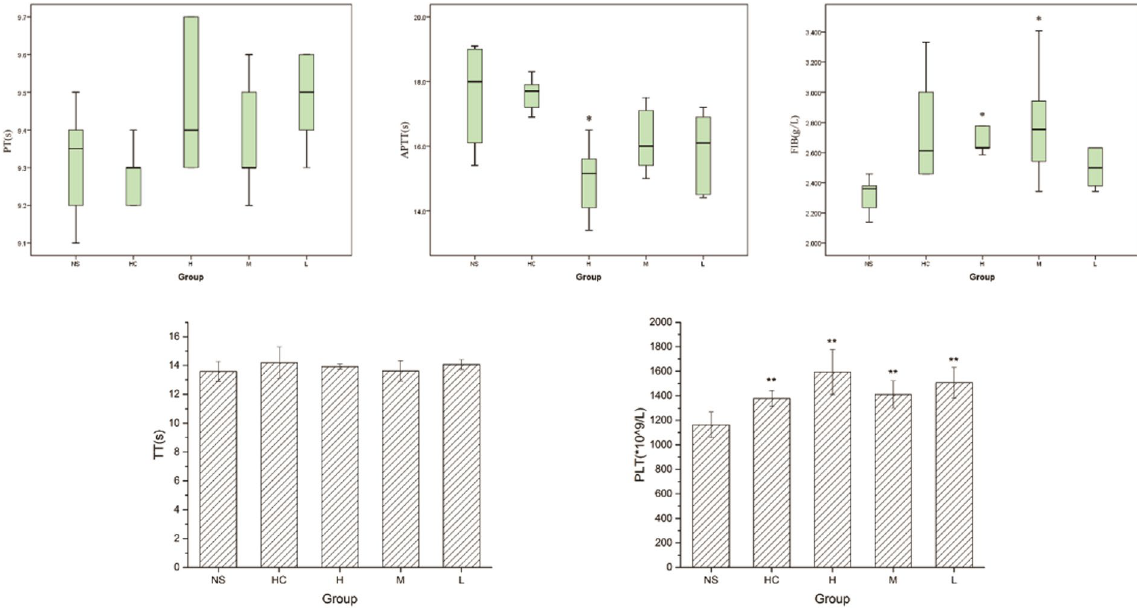
Figure 5. Haemostatic mechanism of egg yolk oil carbon quantum dots (EYO CDs) in mouse tail transection. The male Kunming mice were divided into normal group (treated with saline, NS), positive drug group (treated with haemocoagulase, HC), high-dose EYO CDs, medium-dose EYO CDs, and low-dose EYO CDs. (n = 9 per group). ( A ) The value of prothrombin time (PT) ( B ). The value of activated partial thromboplastin time (APTT) ( C ). The value of fibrinogen (FIB). ( D )The value of thrombin time (TT) ( E ). The value of blood platelets